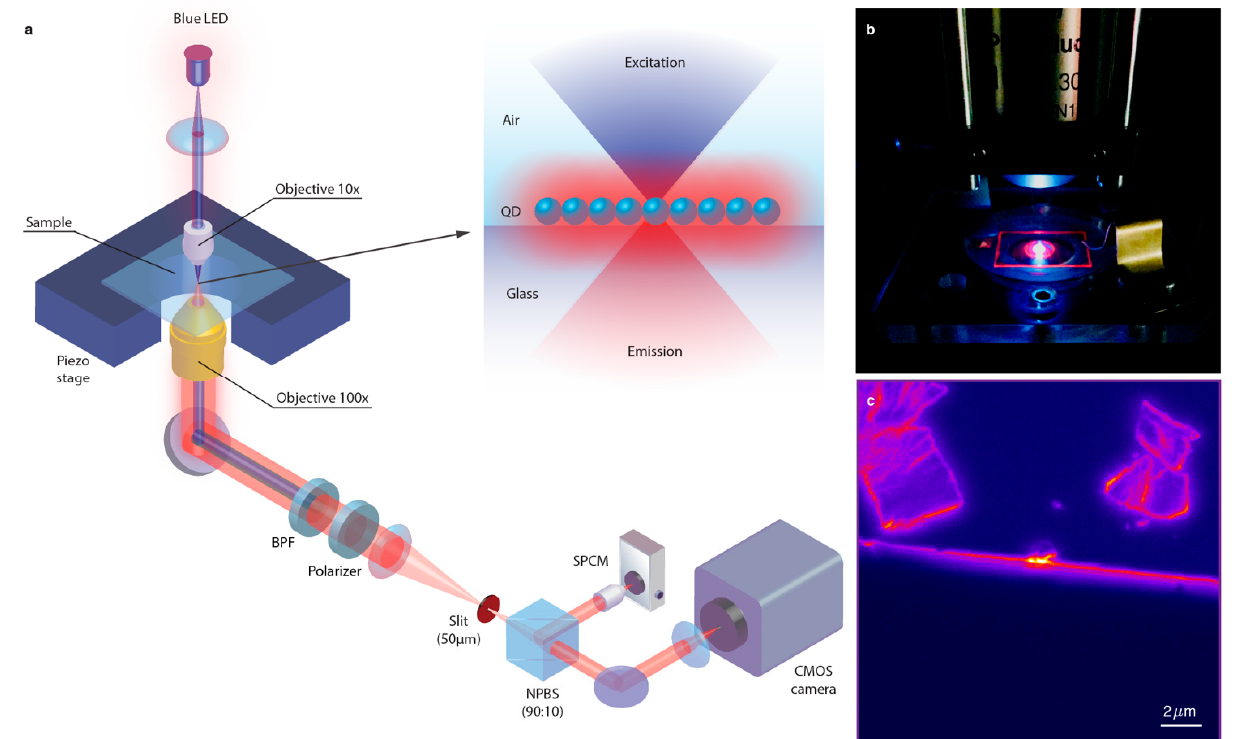
Figure 2. Optical microscopy setup. ( a ) Schematic illustration of the developed setup (not to scale), where the sample is placed on a piezostage and illuminated with a blue light-emitting diode (LED). The emitted light is collected with a 100 × objective lens, filtered with a band-pass filter (BPF) and divided by a non-polarizing beam splitter (NPBS) between a single-photon counting module (SPCM) and a complementary metal oxide semiconductor (CMOS) imaging camera; ( b ) photograph of the sample in the setup; ( c ) fluorescence image of the sample.